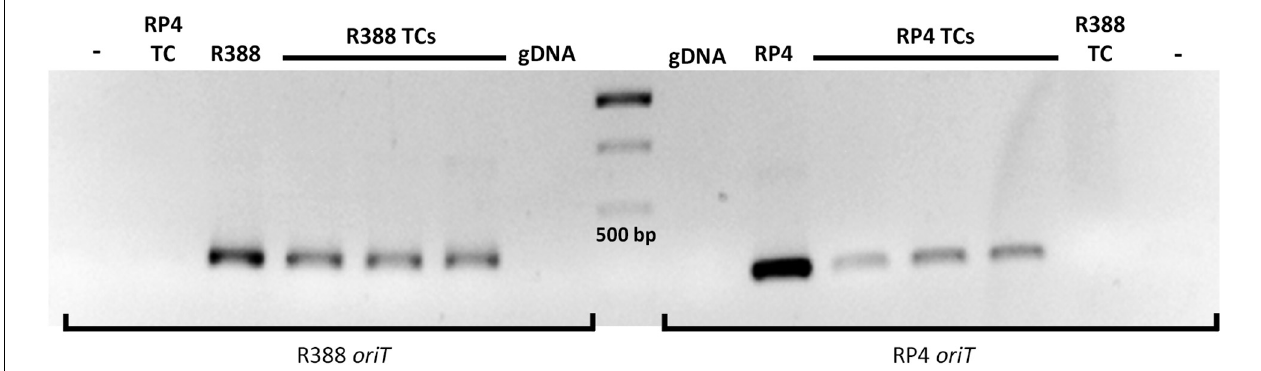
FIGURE 1 | PCR analysis of L. casei 393 transconjugants for the amplification of R388 and RP4 oriT . The oriT amplified by PCR is indicated at the bottom (oligonucleotides indicated in Table 3 ). The template is indicated on top of the gel, and it was either purified DNA (R388 and RP4 as positive controls, and the recipient L. casei gDNA as negative control) or transconjugant (TC) colonies directly used for the PCR reactions. The expected plasmid in the transconjugants (R388 or RP4) is indicated. –, control reaction with no template DNA. The central lane is a molecular weight marker (GeneRuler 1 kb DNA ladder). The 500 bp band is indicated. Expected fragment size: 330 bp for R388 oriT and 280 bp for RP4 oriT